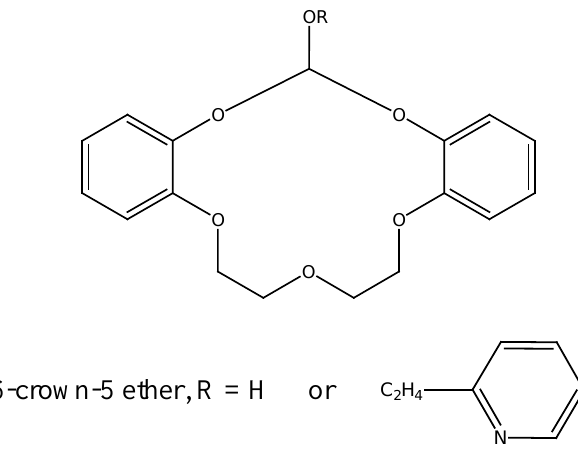
Figure 39. Sym -dibenzo-16-crown-5 ether, R = H